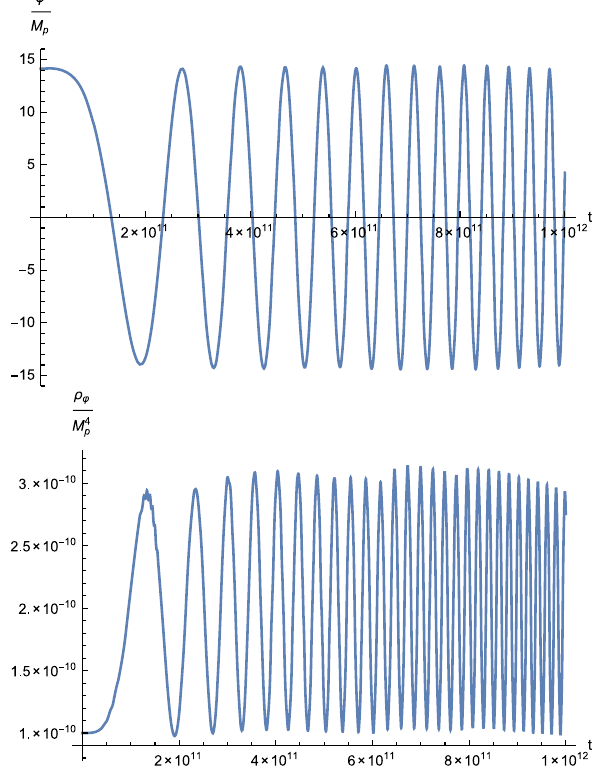
Fig. 1 Plots of the value of ϕ and its energy density ρ ϕ in terms of cosmic time t . We choose the parameters as ξ = 1, M = 10 − 4 M p , m = 10 − 6 M